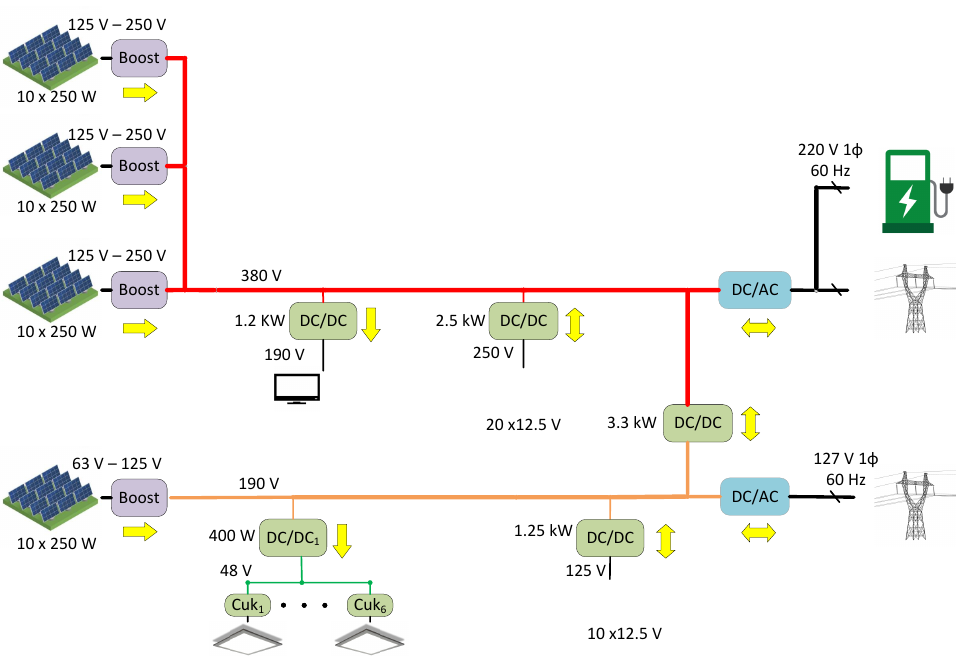
Figure 1. Multibus multivoltage DCMG architecture proposed. Table 2. Line impedance values for different wire gauges and lenghts.